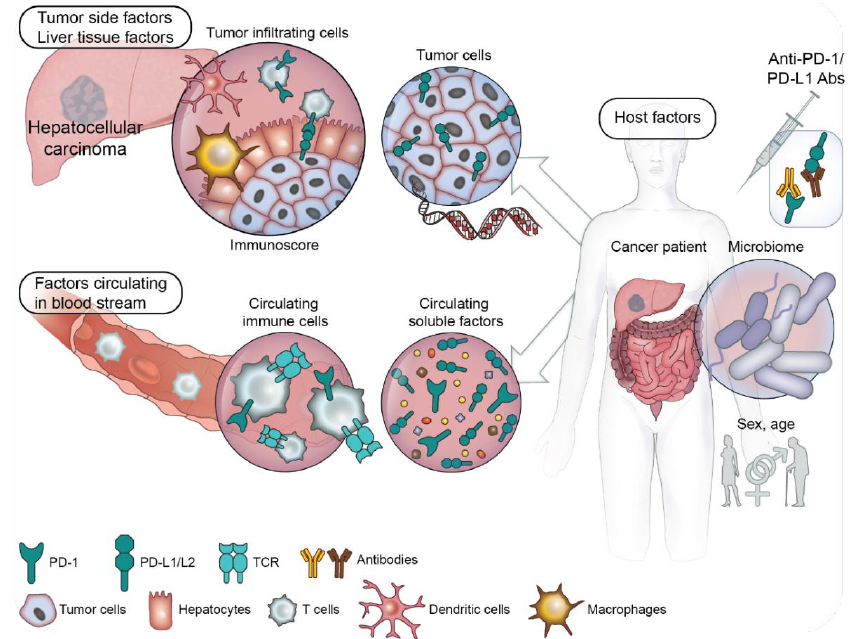
Figure 1. Overview of the predictive factors for PD-1 / programmed cell death ligand 1 (PD-L1) blockade: potential factors to explore in HCC.